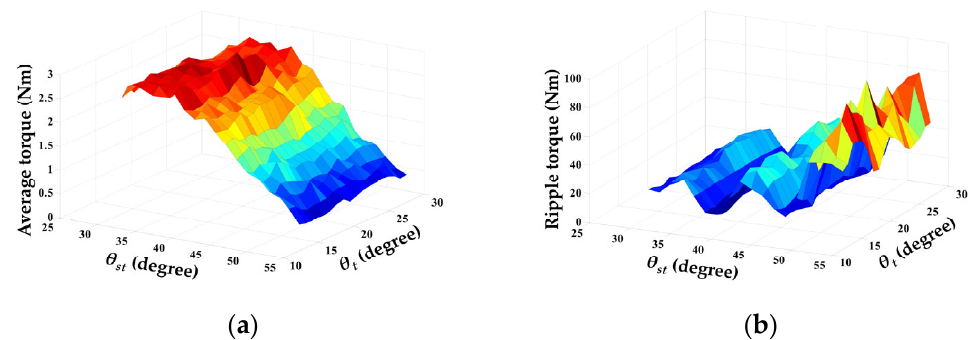
Figure 5. Influence of stator arcs on torque production for a multi-tooth HE-DSDPM: ( a ) average torque and ( b ) ripple torque.